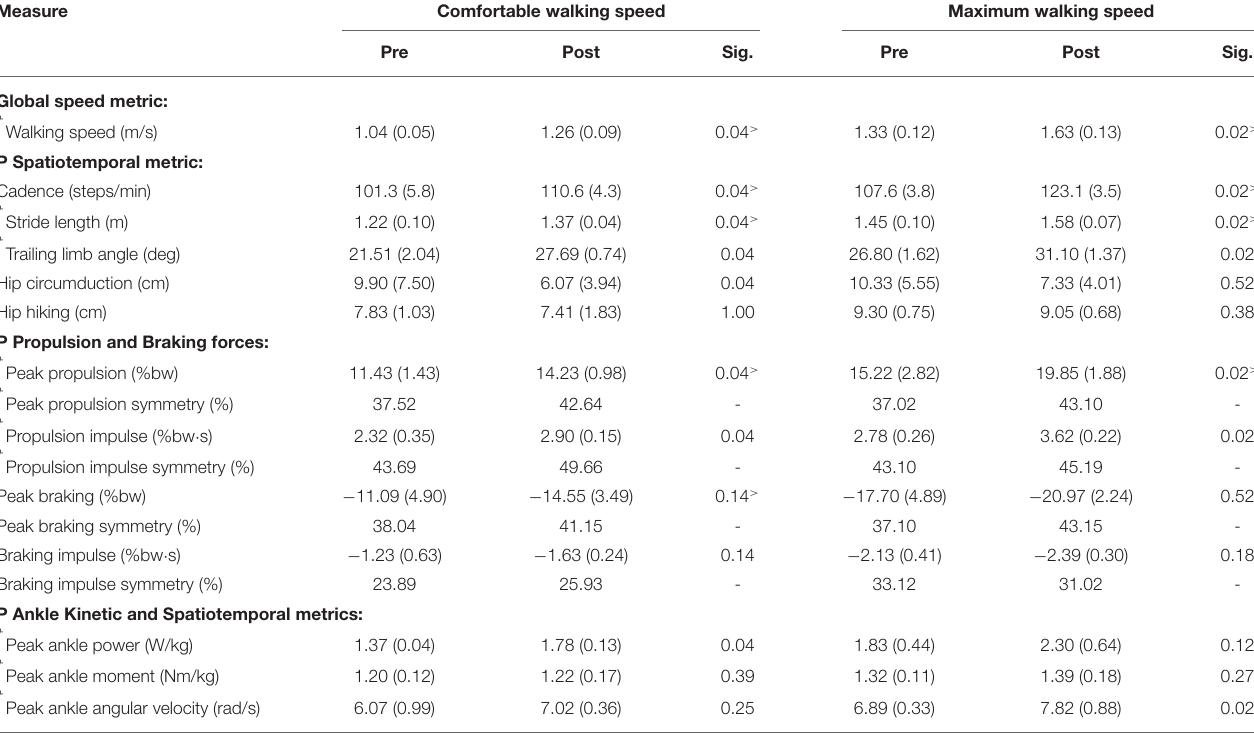
TABLE 1 | Biomechanical effects of REAL training. Measure Comfortable walking speed Maximum walking speed Pre Post